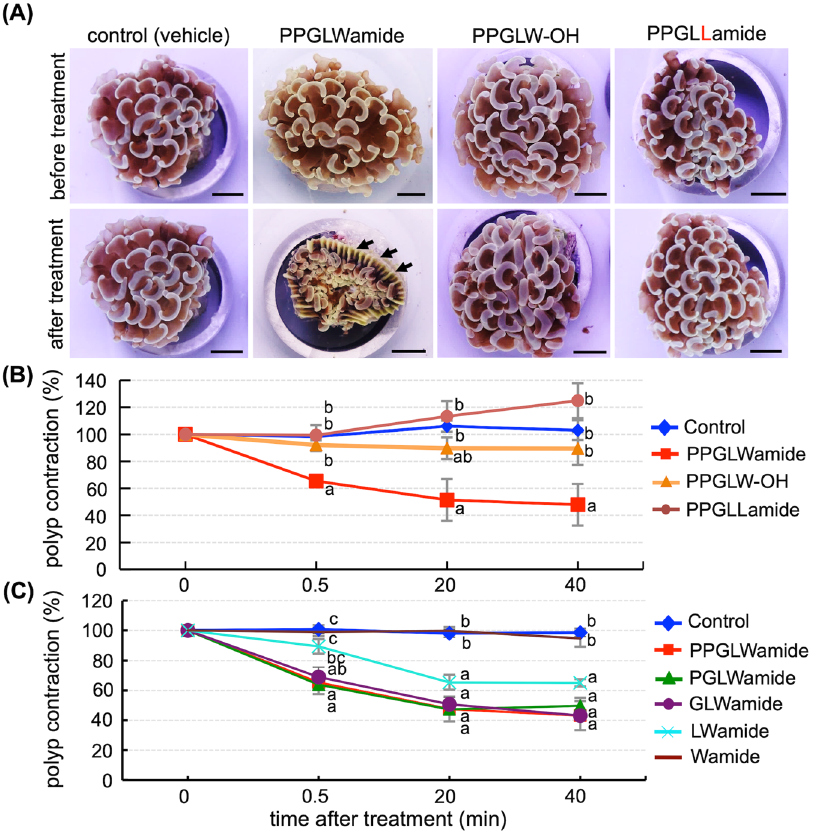
Figure 6. Effects of PPGLWamide peptide on E. ancora polyps. ( A ) Representative pictures of E. ancora before and after treatment with control (vehicle, H 2 O), 10 μ M PPGLWamide peptide, 10 μ M PPGLW-OH peptide, or 10 μ M PPGLLamide peptide. The top panels show the E. ancora polyps before treatment, and the bottom panels show the identical E. ancora polyps at 40 minutes after treatment. Note that only the polyps treated with PPGLWamide peptide exhibited distinct polyp contraction. Arrows indicate the exposed skeleton of E. ancora . ( B ) Quantified effects of the treatment with control (vehicle, H 2 O), 10 μ M PPGLWamide peptide, 10 μ M PPGLW-OH peptide, or 10 μ M PPGLLamide peptide on polyp contraction. ( C ) Quantified effects of the treatment with control (vehicle, H 2 O), 10 μ M PPGLWamide, 10 μ M PGLWamide, 10 μ M GLWamide, 10 μ M LWamide, or 10 μ M Wamide peptides on polyp contraction. In (B) and (C), the rates of polyp contraction (%) were determined by comparing the area of tentacle coverage of E. ancora before treatment (0 min) and after treatment (0.5, 10, 20, 40, and 60 minutes). Each data point represents the mean ± SE (n = 3 different colonies). Different lower case letters above the symbols depict significant differences (P < 0.05) among the groups at each time